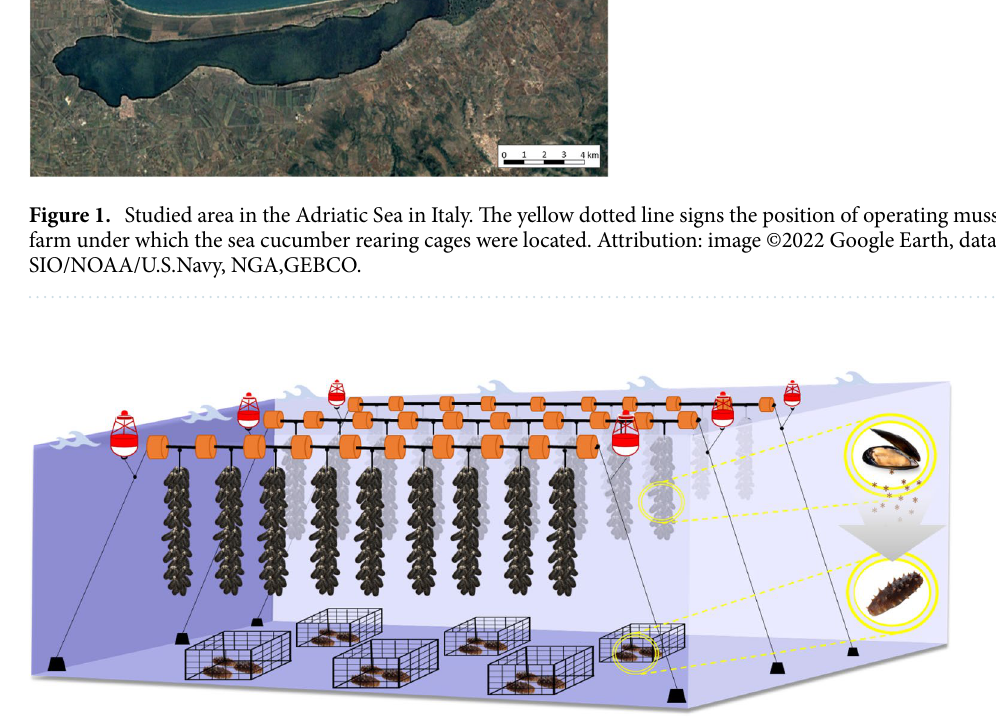
Figure 2. Experimental scheme of Integrated Multitrophic Aquaculture, using Holothuria tubulosa and Holothuria polii as extractive species under a mussel ( Mytilus galloprovincialis ) farm .